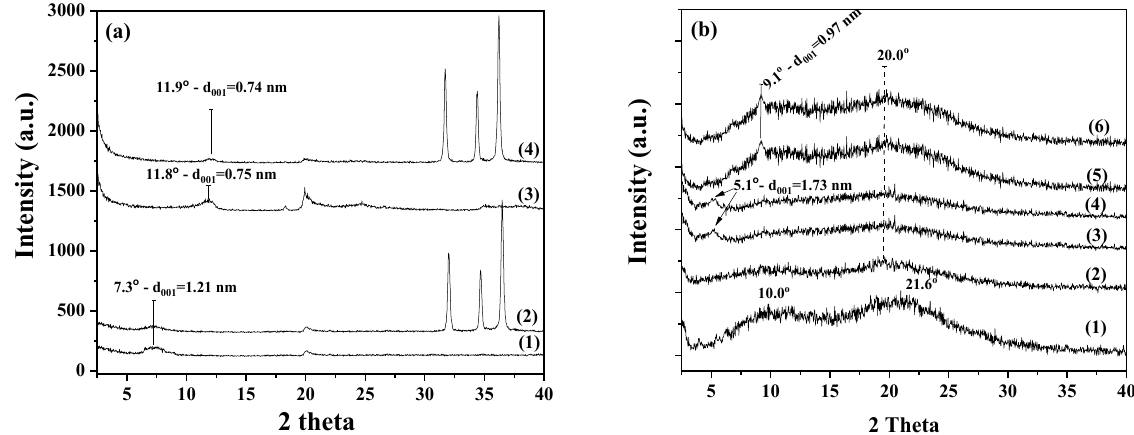
Figure 2. XRD plots of ( a ) pure Mt (1), ZnO@Mt nanohybrid (2), pure HNT (3), and ZnO@HNT nanohybrid (4) and ( b ) pure CS film (1), CS/PVOH film (2), CS/PVOH/3ZnO@Mt film (3), CS/PVOH/6ZnO@HNT film (4), CS/PVOH/3ZnO@Mt film (5), and CS/PVOH/6ZnO@HNT film (6).